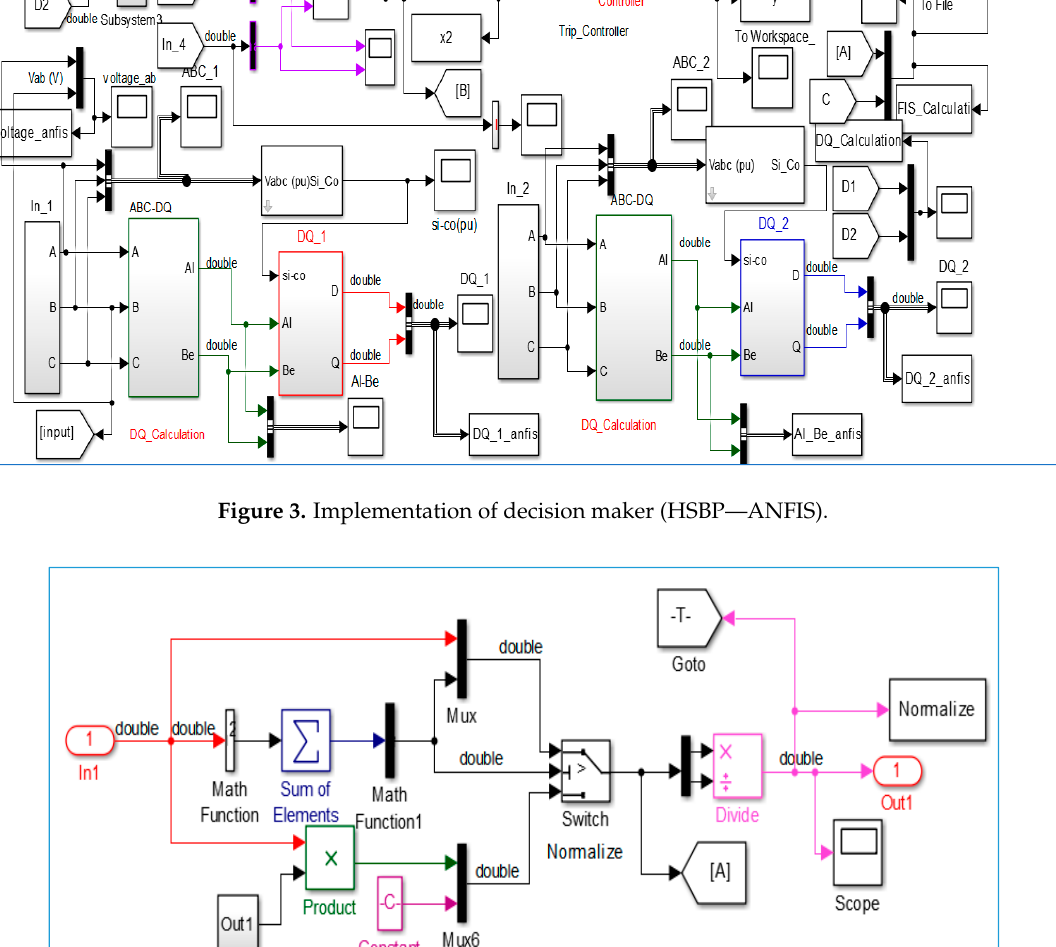
Figure 4. Proposed the sample model demonstrated the active/reactive vector magnitude normalization, tested in the feeder